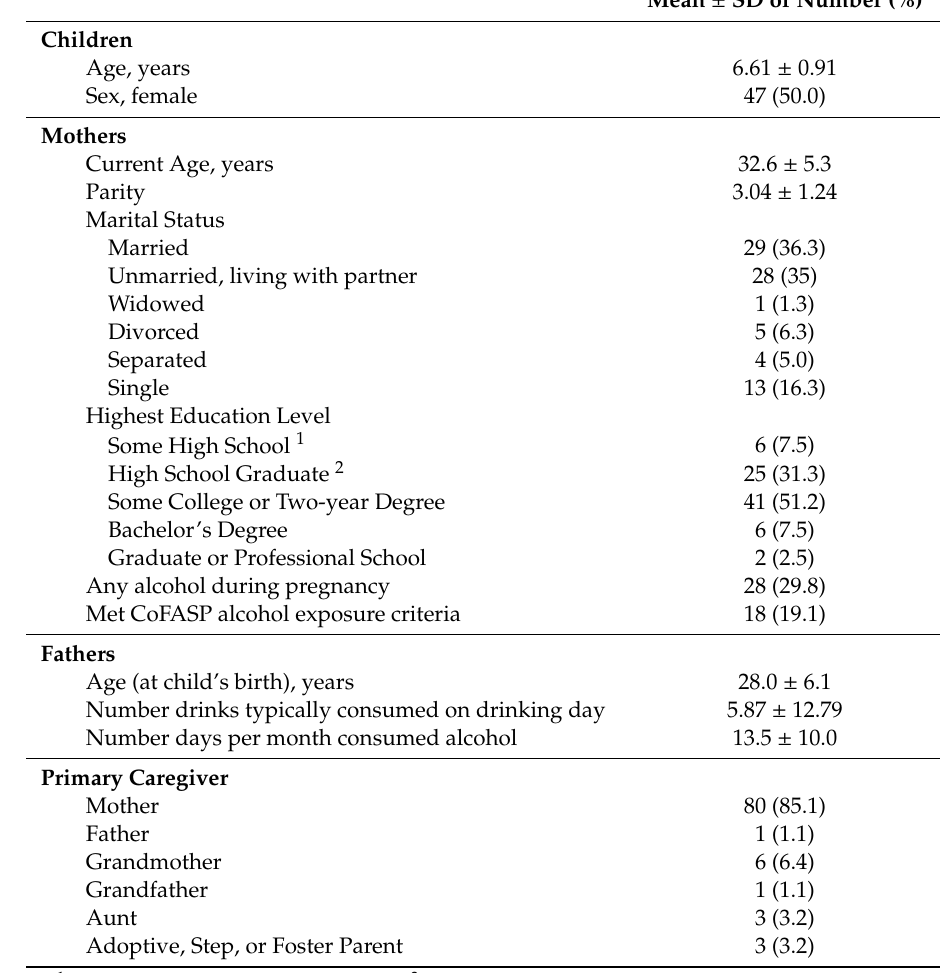
Table 1. Characterization of Sample.